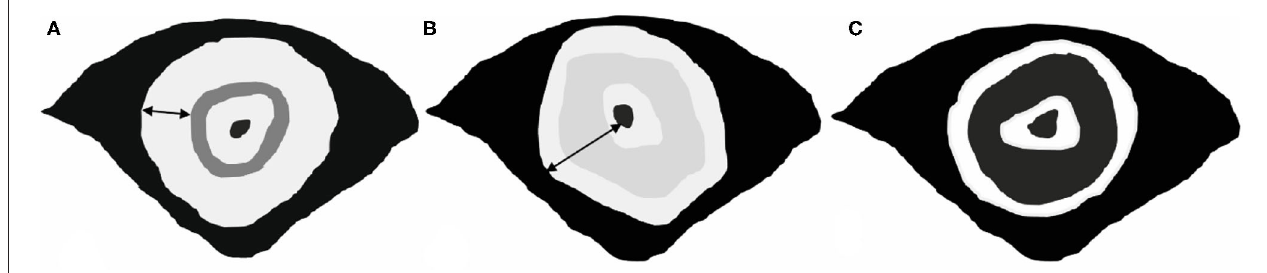
FIGURE 1 | Patterns of SRCC on DWI. (A,B) Definition of thick-ring signs. The wide of the high-SI ring is above 5mm, which represents tumor tissue infiltrated all mural layers. (C) Definition of a thin-target sign. The thick concentric mural with high SI of thin inner and outer layers ( < 5mm) and low SI of the middle layer, which was assumed non-tumor